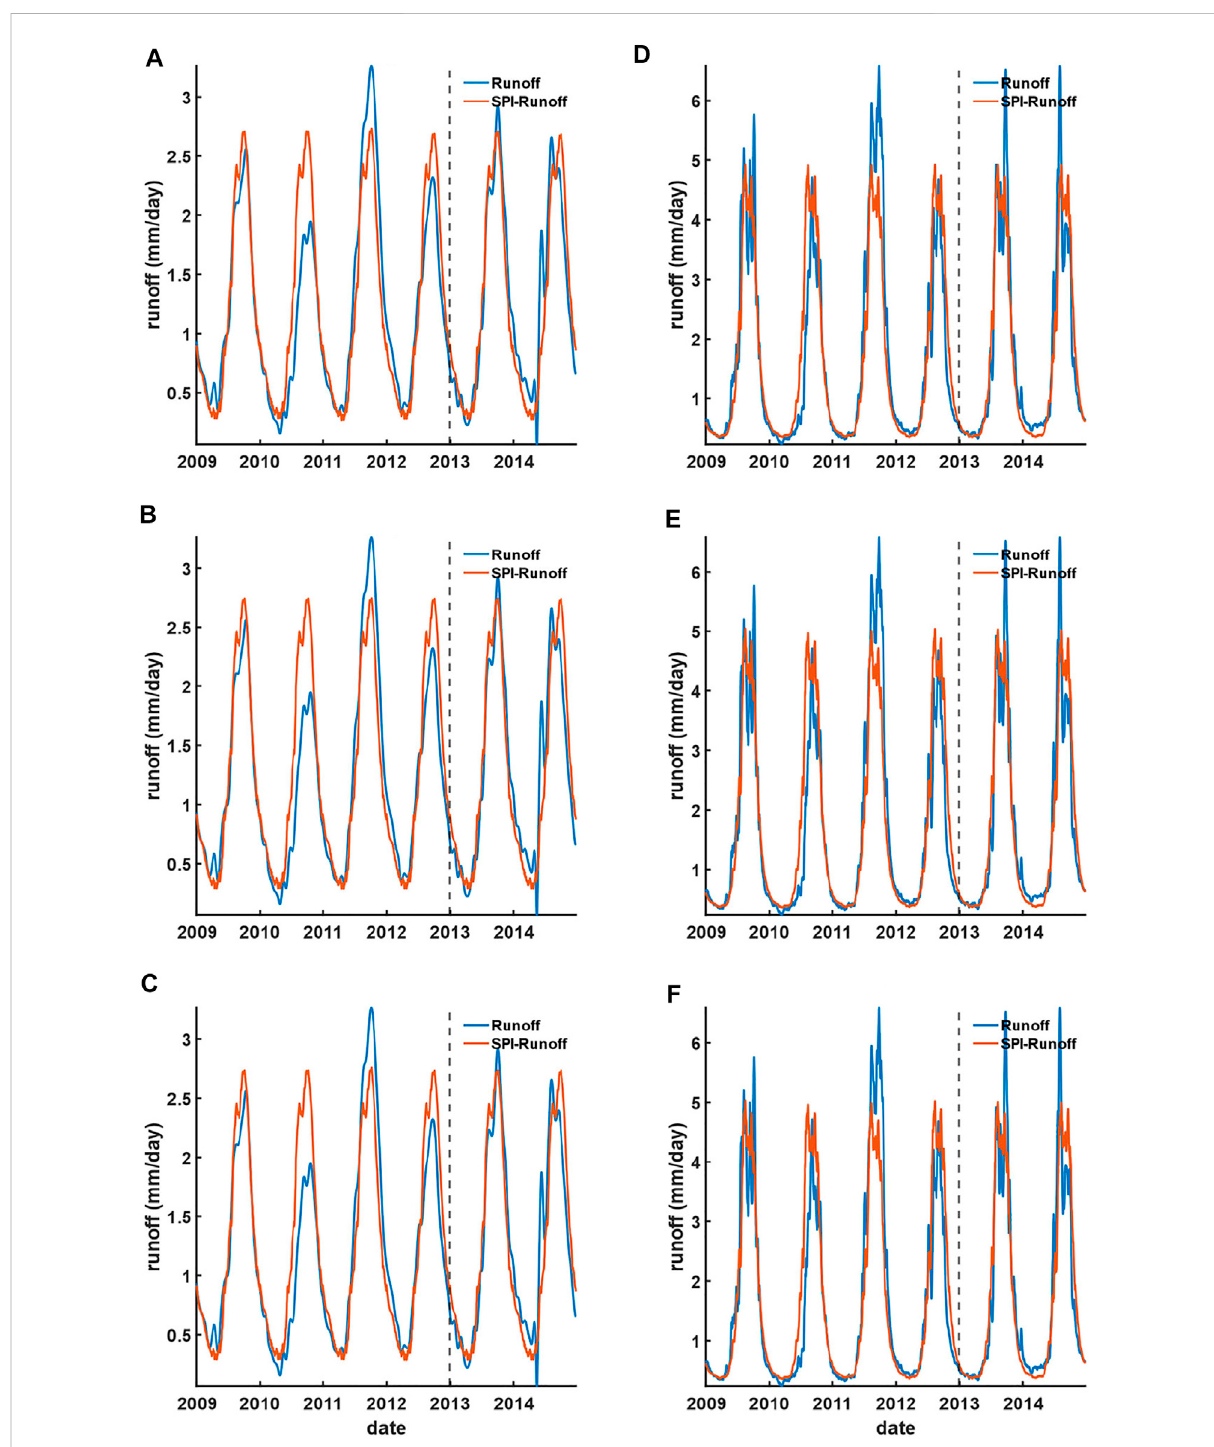
FIGURE 10 Reconstructed (from 2009 to 2012) and forecasted (from 2013 to 2014) runoff using the upstream GPM-TRMM SPI against in situ runoff at the TC-CD and Kratie stations based on (A and D) linear regression, (B and E) ANN, and (C and F) LSTM models,